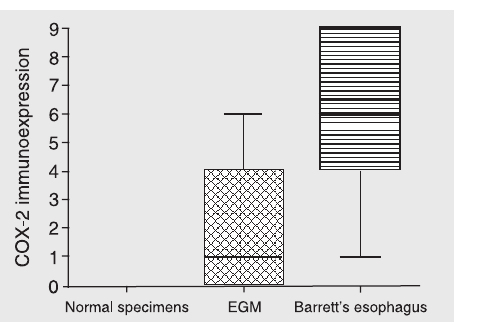
Figure 2. Examples of cyclooxy- genase-2 (COX-2) immunoreac- tivity. A , No COX-2 expression in the normal specimen (200X). B , Immunohistochemical stain- ing in ectopic gastric mucosa (arrows; 200X), and C , detail of the positive immunoexpression in the same specimen (400X), represented by a gray layer (ar- rows). D , COX-2 immunoex-